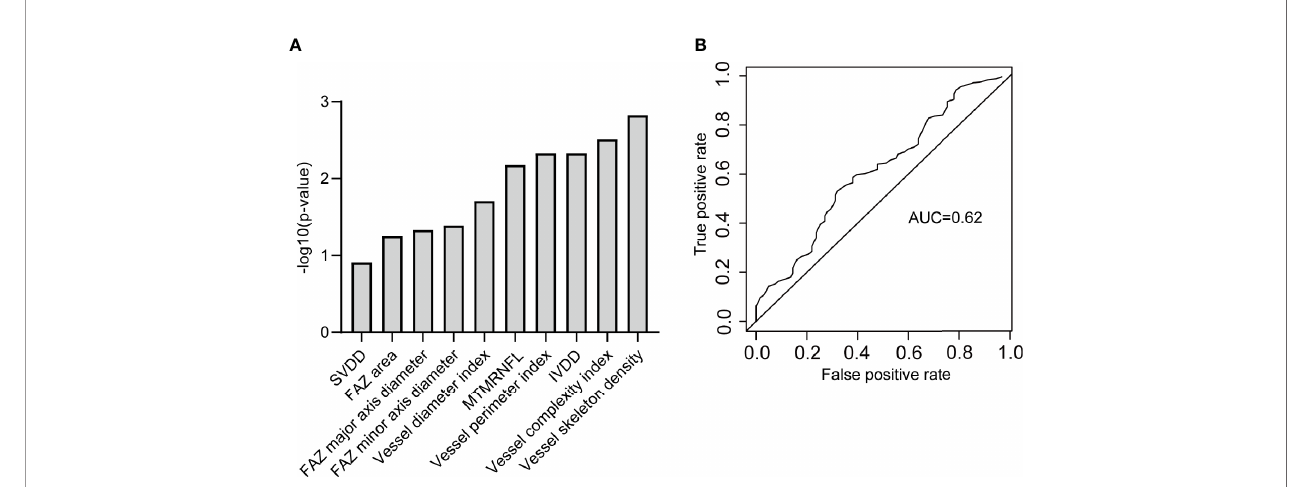
FIGURE 6 | The OCTA metrics related to DR. (A) The OCTA metrics related to DR and identi fi ed by stepwise regression. (B) The ROC curve of the logistic regression model to classify DR participants and diabetic free of DR participants. SVDD, superior vessel density in the deep layer; FAZ, foveal avascular zone; MTMRNFL, mean thickness of macular in the retinal nerve fi ber layer; IVDD, inferior vessel density in the deep